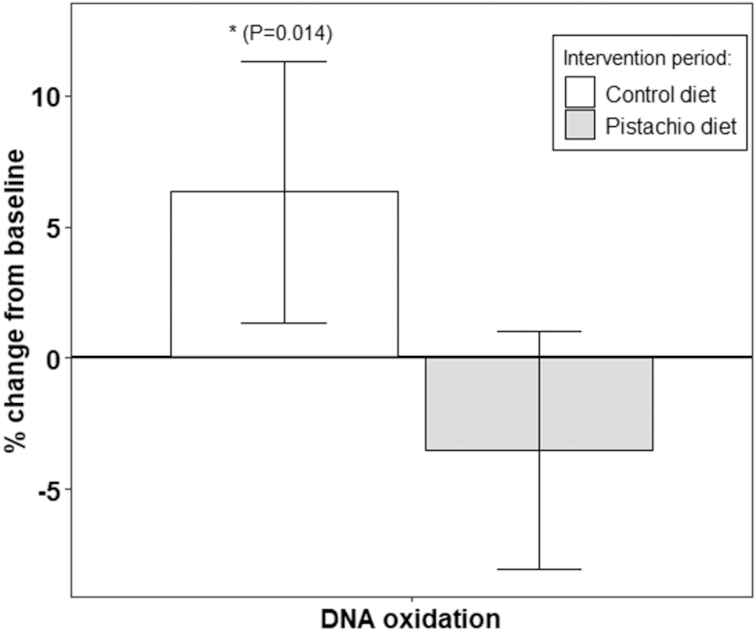
Percentage changes in plasma 8-OHdG levels in the course of the interventions. Results are means (95% CI) of 2 replicate samples for each point. *Significant compared with pistachio diet (P < 0.05). n = 49, both periods are considered. 8-OHdg, 8-hydroxydeoxyguanosine.